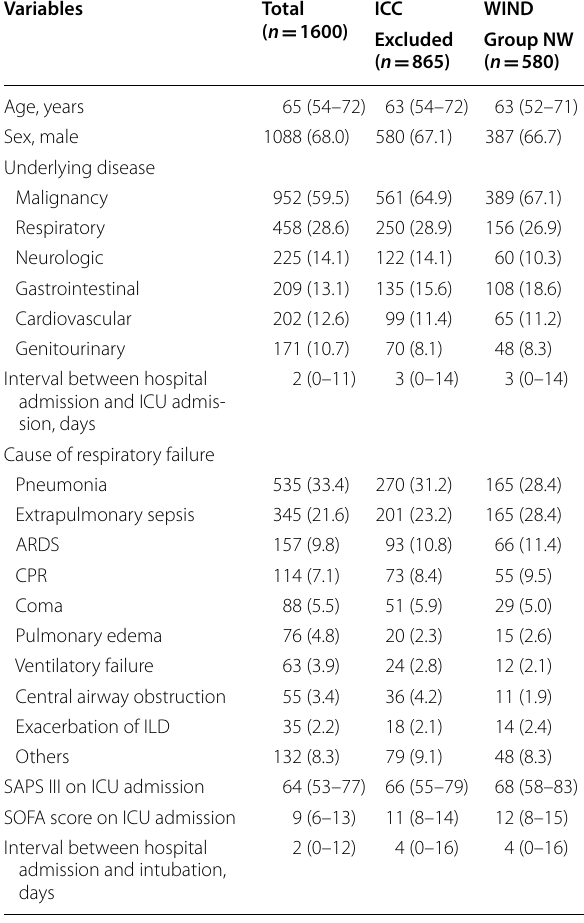
Table 1 Baseline characteristics of the total cohort, excluded patients by ICC classification, and Group